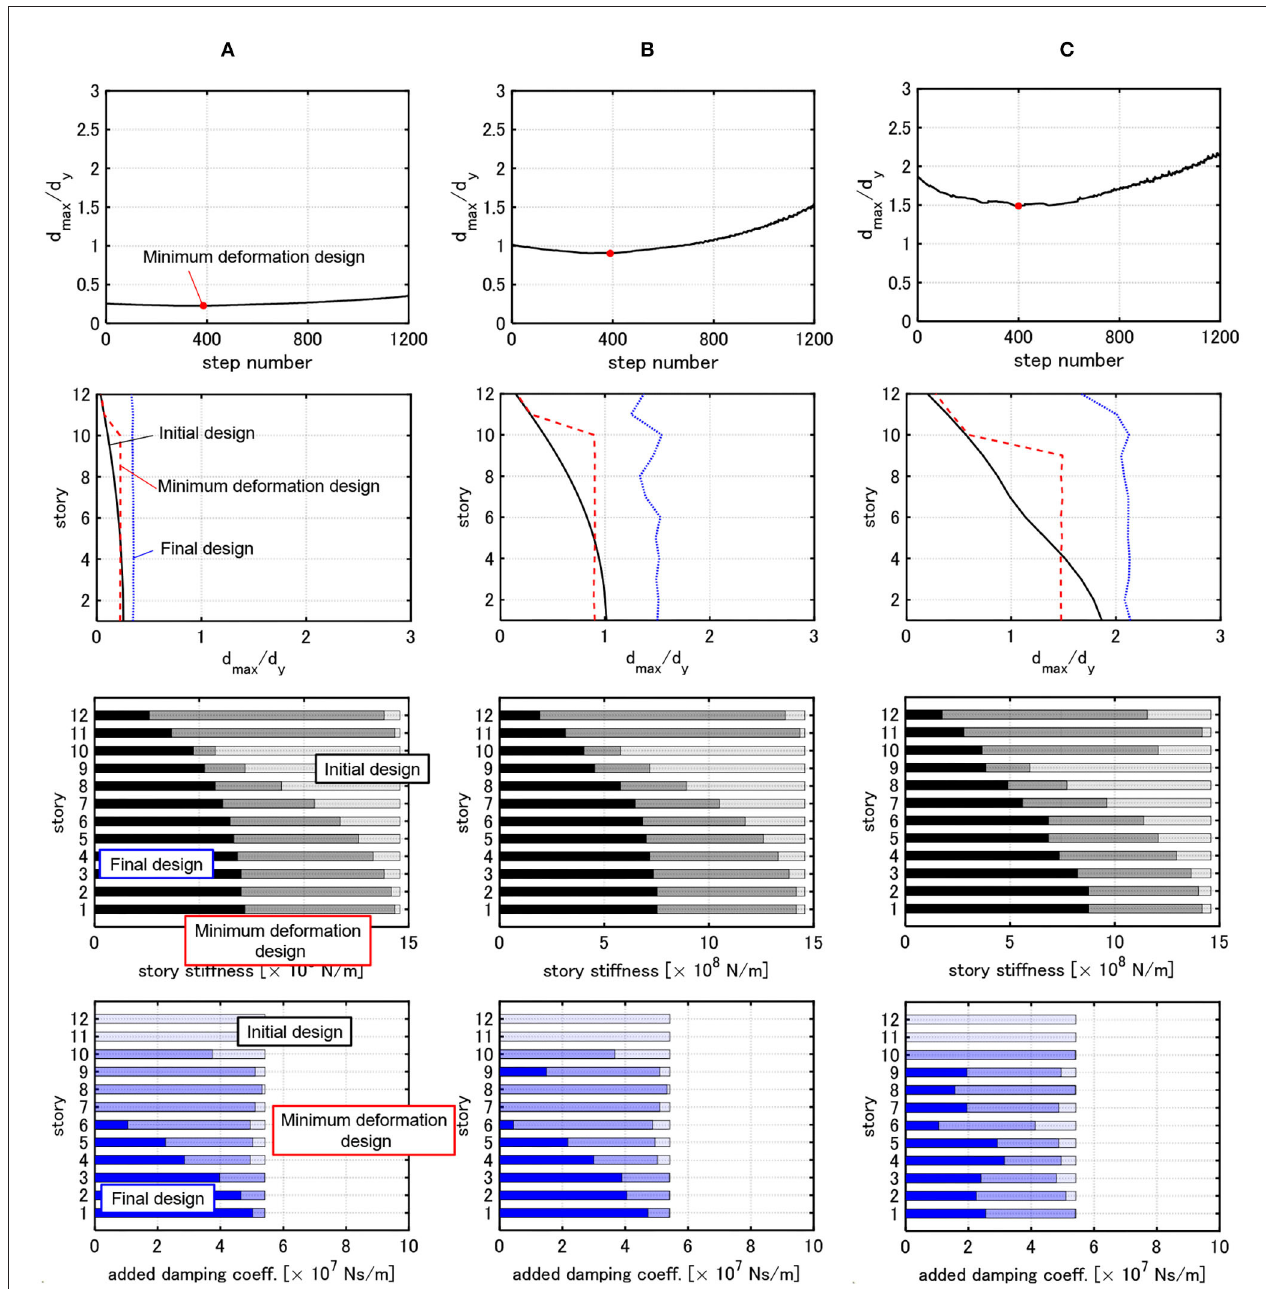
FIGURE 6 | Change of maximum deformation, distribution of d max, i / d y , distribution of story stiffness and distribution of damper damping coefficient of 3 cases with W cF = 20 × 10 7 [ Ns / m ]. (A) Model designed under critical double impulse with V = 0.25[ m / s ]. (B) Model designed under critical double impulse with V = 1.0[ m / s ]. (C) Model designed under critical double impulse with V = 1.5[ m / s ].